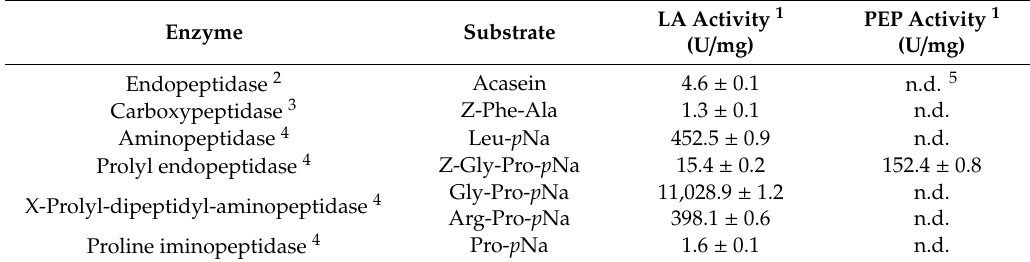
Table 1. Characteristics of peptidases from L. acidophilus 5e2 (LA) and prolyl endopeptidase from A. niger (PEP) used for gliadin